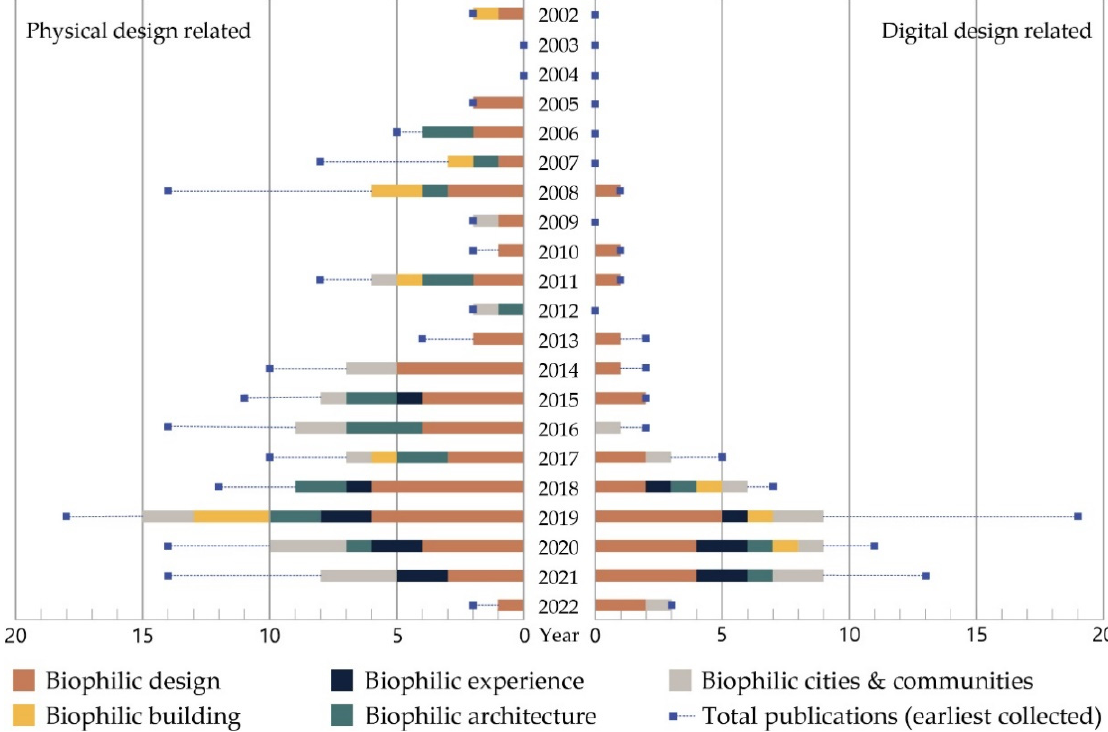
Figure 3. Selected publications and related keywords.